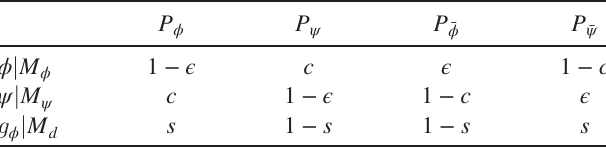
TABLE II. Data table for our operational scenario. P